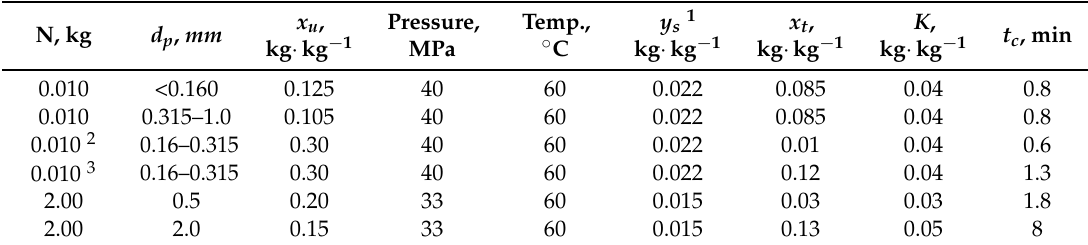
Table 5. Model parameters for the extraction of lipids from Nannochloropsis oculata [30] ( t r = 2.8–3.5 min). Flow pattern: five